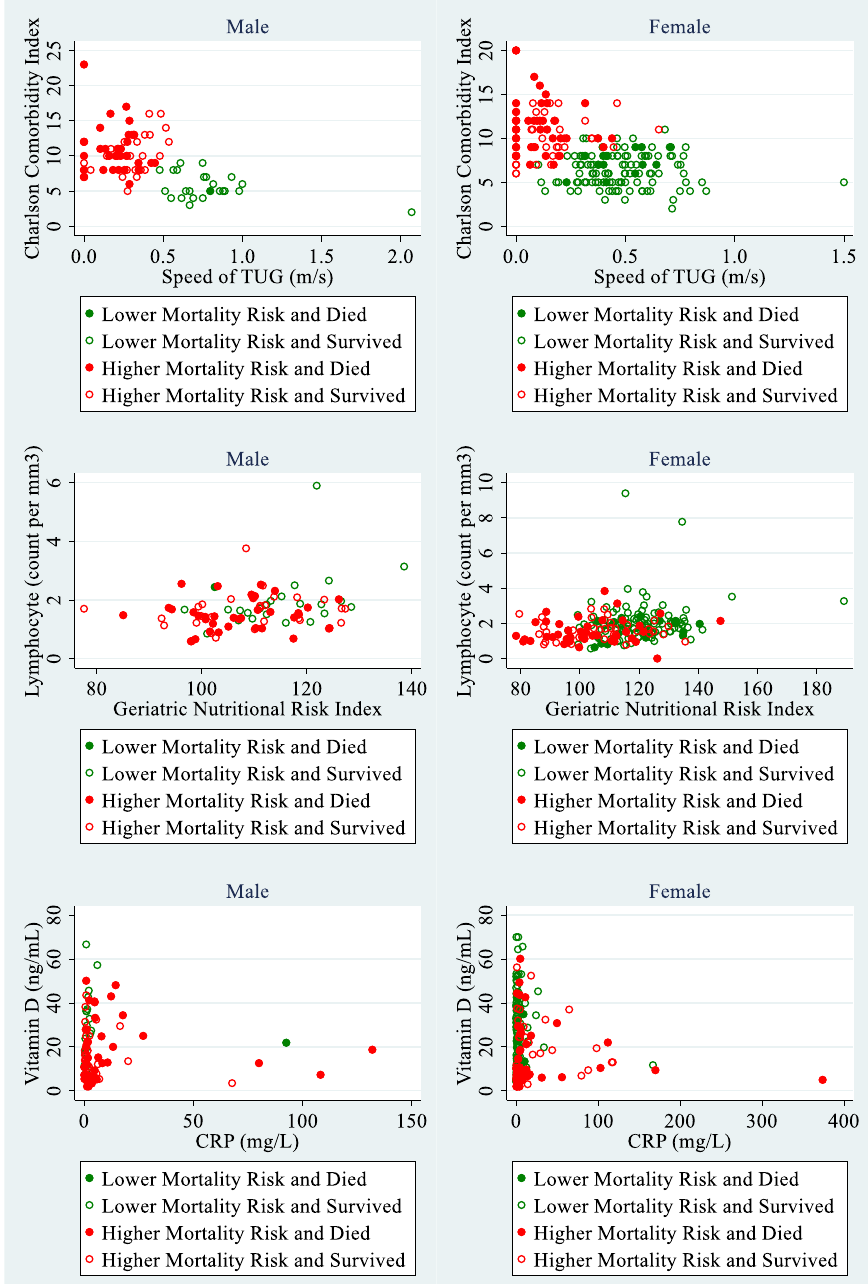
Figure 3. Classification of geriatric patients into the category of lower mortality risk and the category of higher mortality risk based on seven most important predictors identified by both: The stepwise backward selection method and the iterative BMA approach. Results from the 10-fold cross-validation of the multivariable Cox PH model.